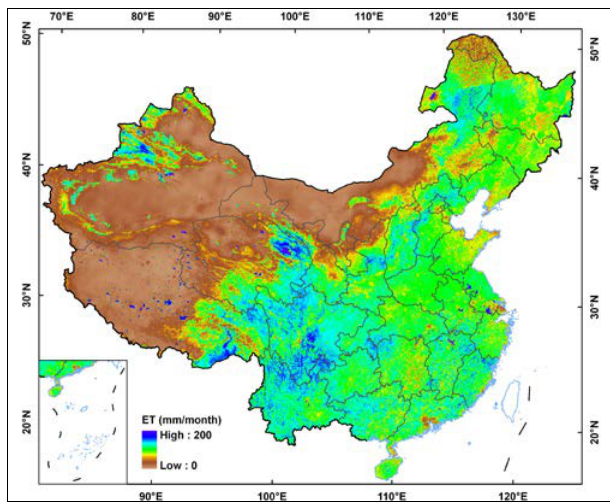
Figure 3. Monthly ET at 1 km x km spatial resolution; China,